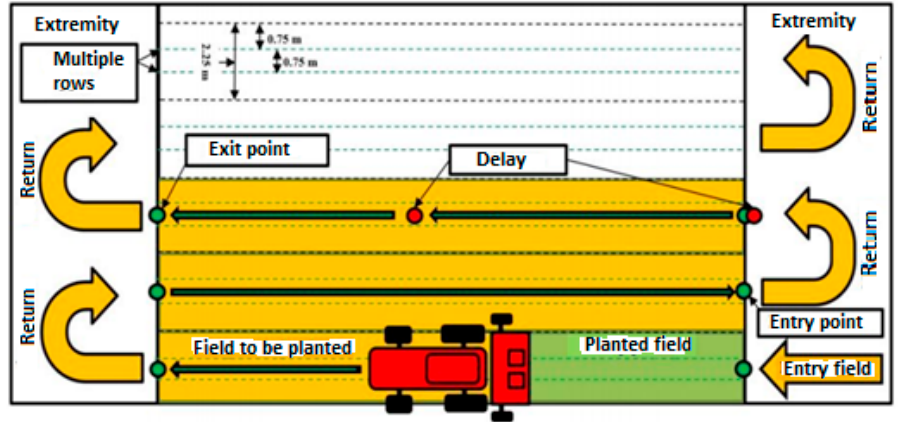
Figure 2. Planting scheme of energetic willow cuttings.